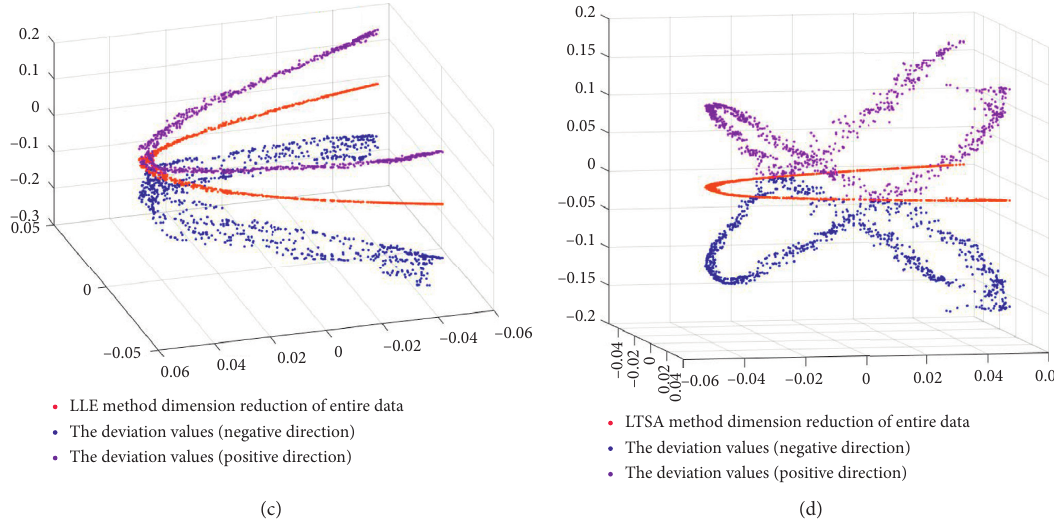
Figure 14: Dimension reduction and deviation value results for entire noisy S-shaped dataset.